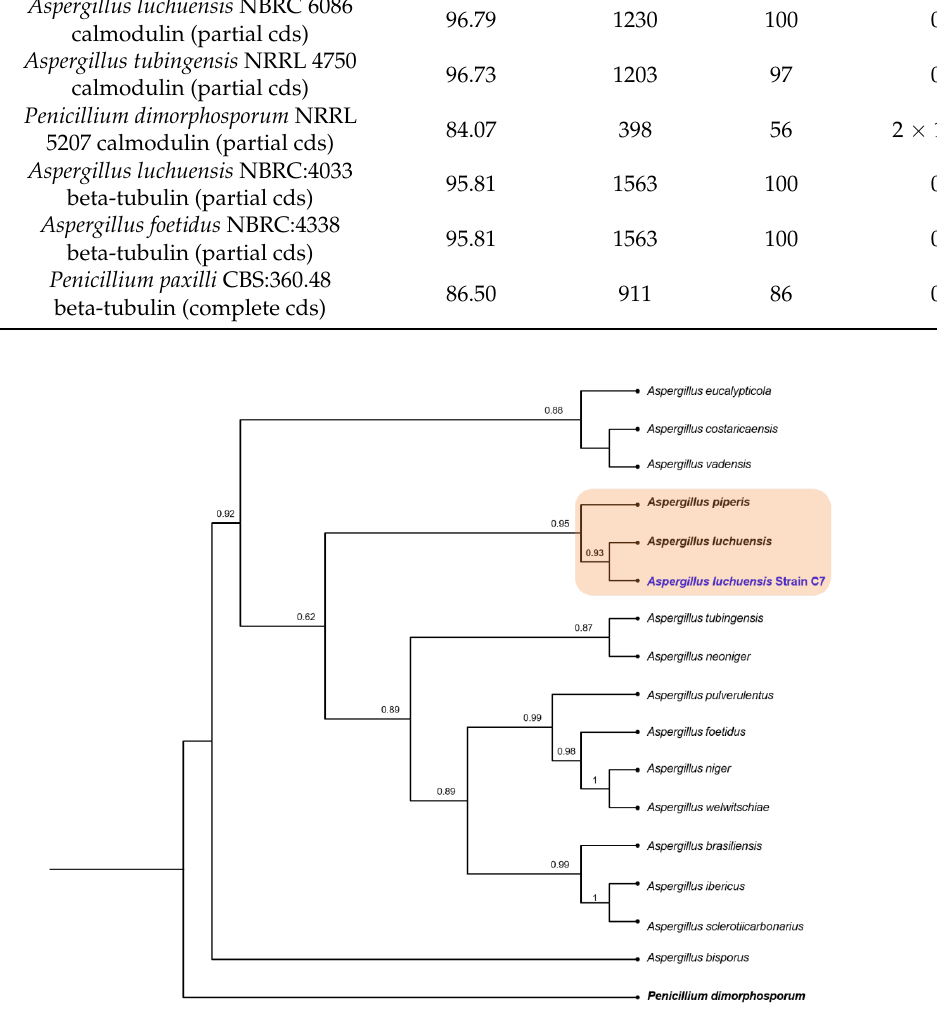
Figure 5. Maximum likelihood phylogeny based on concatenated alignments of 28S, calmodulin and β -tubulin sequences. Approximate likelihood-ratio test (aLRT) for branches is shown in nodes. Penicillium dimorphosporum was used as outgroup. The scaled bar under the tree indicates substitutions per site. Table 3. Genomic coherence for a set of long-reads of strain C7 against representative closest fungal genomes.